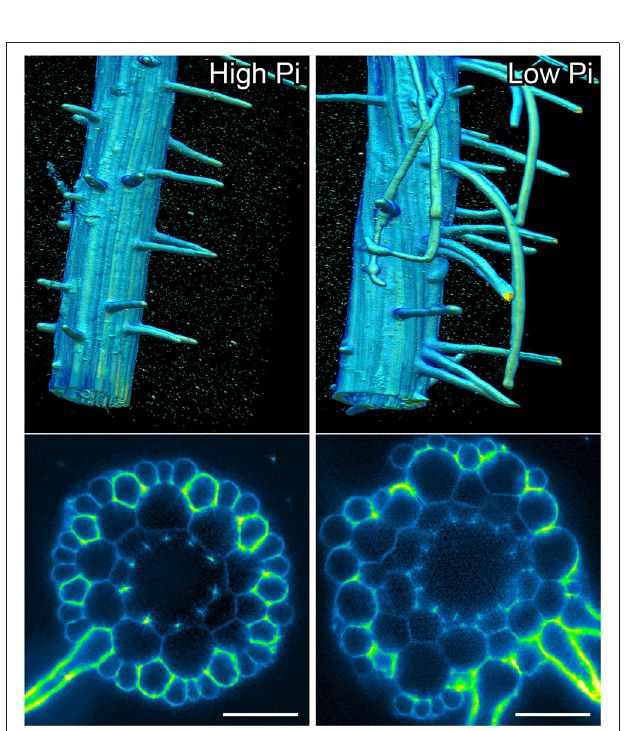
FIGURE 6 | Light sheet imaging reveals atypical root hair patterning scenarios under low Pi. Anatomy of a mature part of Arabidopsis under high Pi (Left) and low Pi conditions (Right) . Multi-view recording along six directions captured using Light Sheet Fluorescence Microscopy. A 3D reconstruction (Arivis Vision 4D software) of the fused image stack is shown in the upper panel and a single slice cross section is presented in the lower panel. Roots were stained with propidium iodide. Scale bars = 50 µ m.